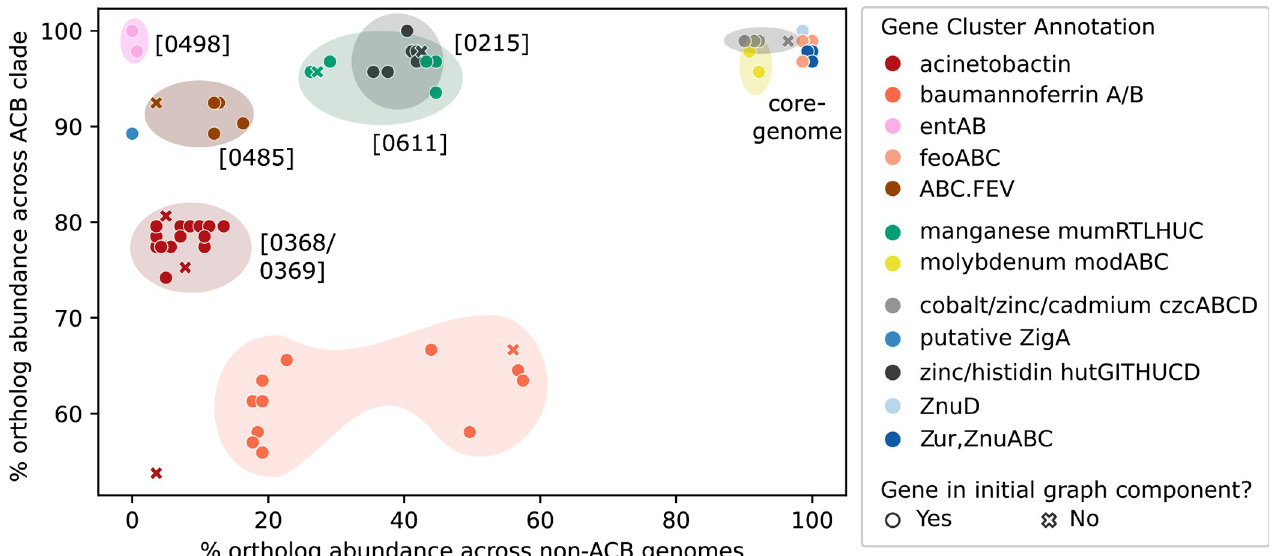
Fig 8. Abundances of micronutrient acquisition genes/clusters of Ab ATCC 19606 within and outside the ACB clade. Absolute abundances were based on cluster-evaluation using microsynteny. Gene clusters are annotated with the ESGC ACB identifiers in Fig 5. Genes that are part of a cluster but missed by the initial ESGC compilation share the same color but are marked as x. Gene clusters at the top right, e.g., feoABC, represent micronutrient acquisition clusters belonging to the genus’ core genome. Gene clusters at the top left, e.g., entAB, are confined to the ACB clade where they are ubiquitously present.